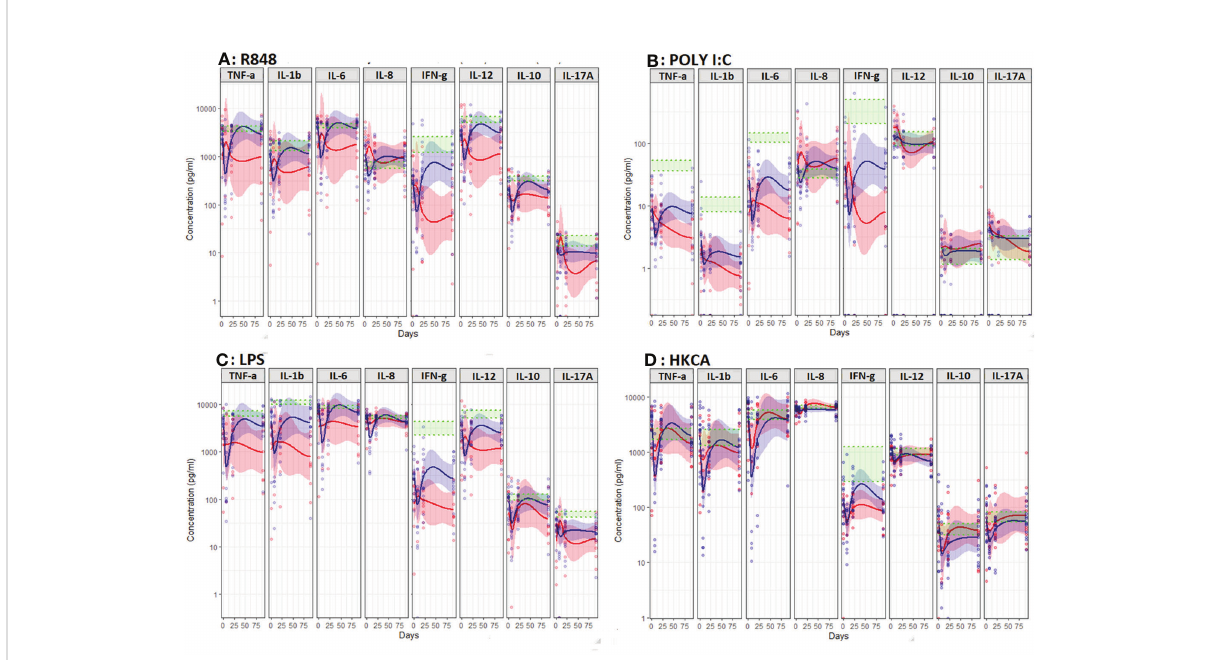
FIGURE 7 Induced immune response assessed by TruCulture ® during treatment in CT-treated patients strati fi ed according to 12-months survival (death within 12 months (red, n=16)) and survival beyond 12 months (blue line, n=8)). (A) Resiquimod (R848), (B) polyinosinic:polycytidylic acid (poly I: C), (C) Lipopolysaccharide (LPS) and (D) heat-killed Candida albicans (HKCA). Corresponding 95% con fi dence interval shown as the light red respectively blue area. The shaded green area represents the in-house reference level (95% con fi dence interval between the green dotted